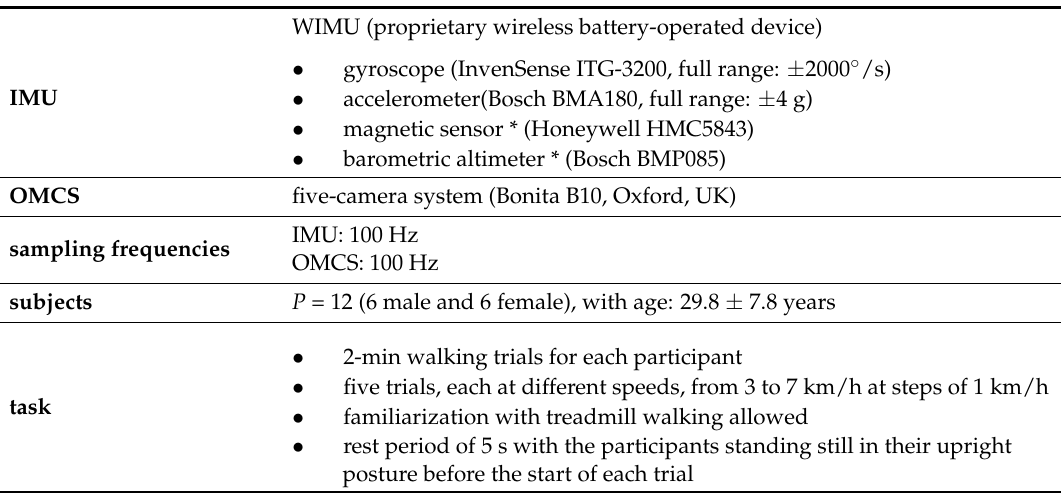
Table 1. Setup and experimental protocol for the TW dataset [10].